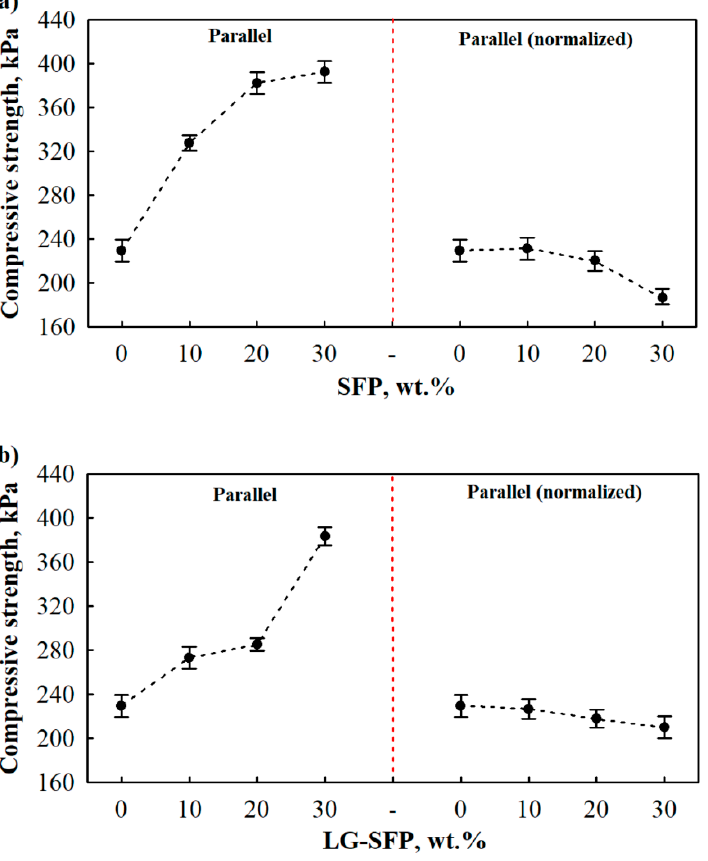
Figure 7. Compressive strength of SFP and LG-SFP modified PUR foams: ( a ) SFP modified PUR foam parallel to foaming direction and ( b ) LG-SFP modified PUR foam parallel to foaming direction.